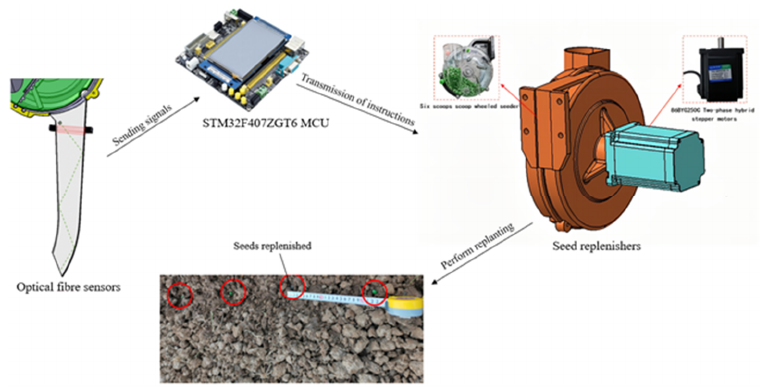
Figure 6. Diagram of the replay system start-up